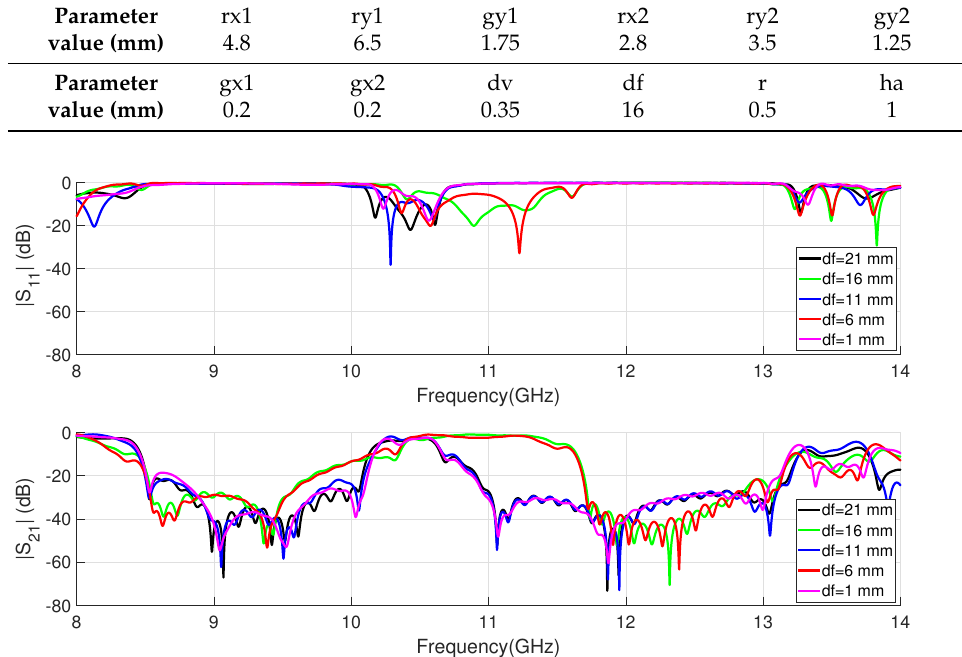
Figure 6. Simulated S parameters of the dual-band EBG filter for different distances (df) between filters. The response of this type of EBG filter is greatly influenced by the short circuit